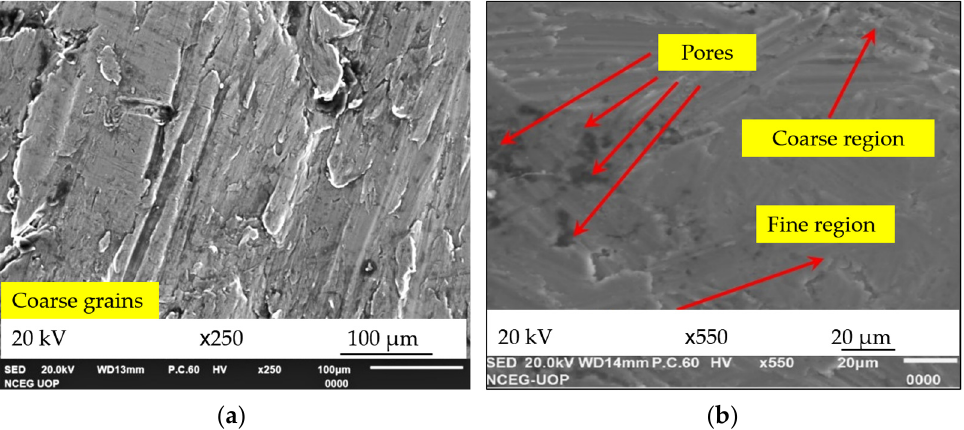
Figure 7. SEM image of ( a ) AA7075 (base alloy, sample 1), ( b ) AA7075-5wt %SiC-3wt %RHA-1wt %CES (n-HMMC, sample 4) agglomerations of reinforcements.